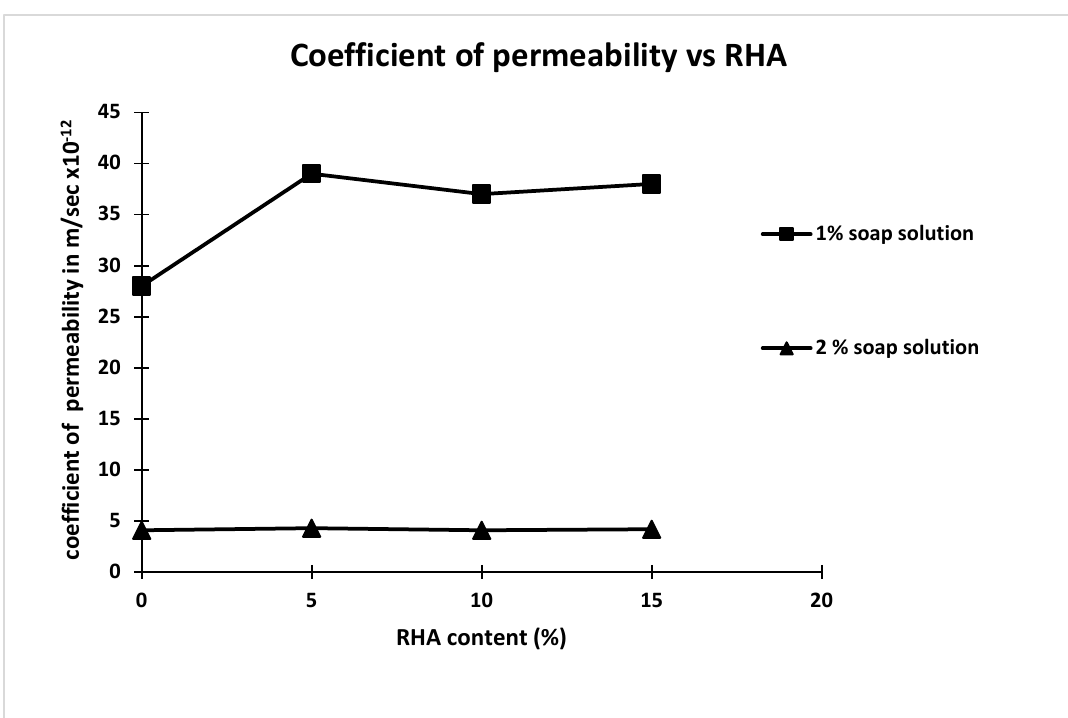
Figure 7. Coefficient of permeability vs. RHA for 1 and 2 percent soap solution.